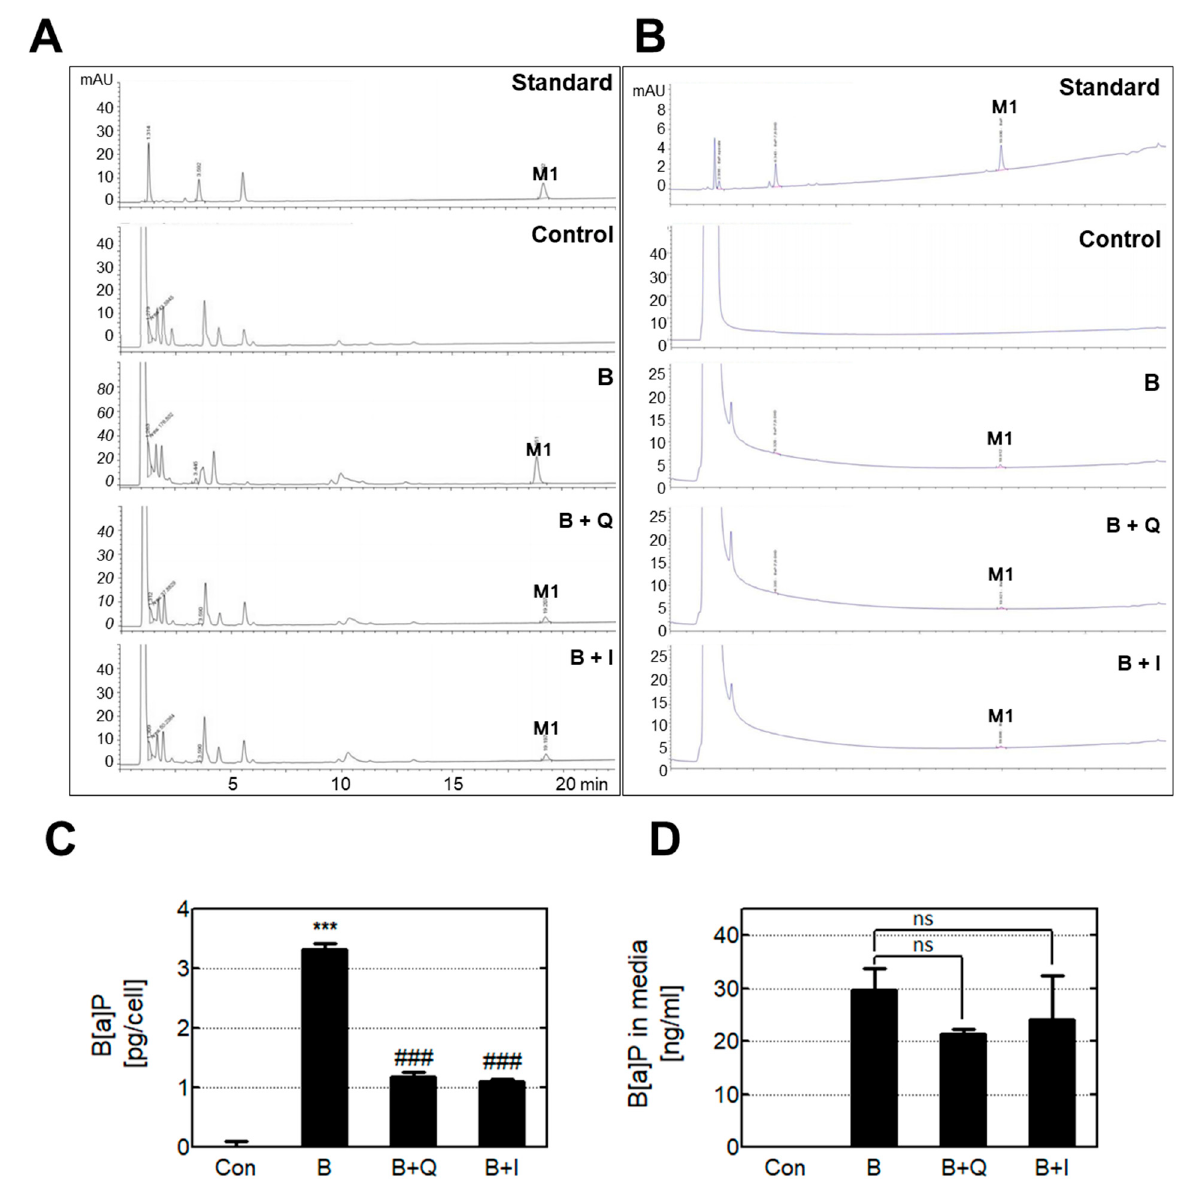
Figure 3. Reduction of intracellular B[a]P by quercetin and isorhamnetin. ( A ) Intracellular B[a]P and ( B ) remaining B[a]P in the cell culture media were analyzed by HPLC. These data were quantified and are presented graphically for ( C ) Intracellular B[a]P and ( D ) remaining B[a]P in cell culture media. *** p < 0.001 compared with the control; ### p < 0.001 compared with B[a]P-treated cells; ns: not significant. M1: benzo[a]pyrene (B[a]P); Con: control; B: benzo[a]pyrene (B[a]P) (10 µ